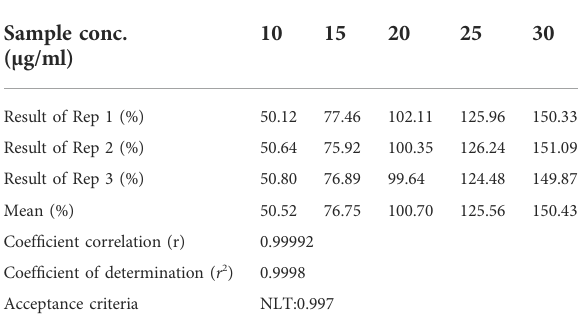
TABLE 3 Linearity and range of the assay method.